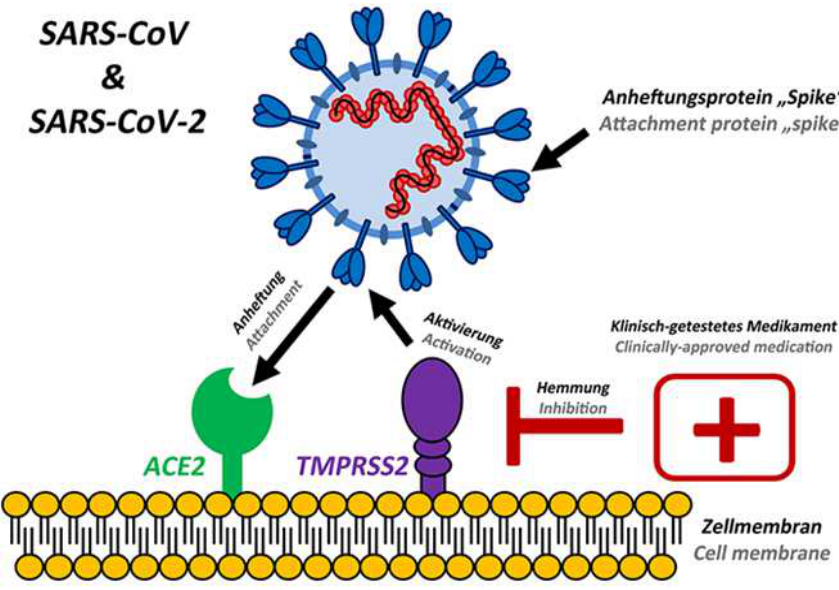
Figure 12. Interaction between COVID-19, ACE2, and TMPRSS2 [46,49] 5.